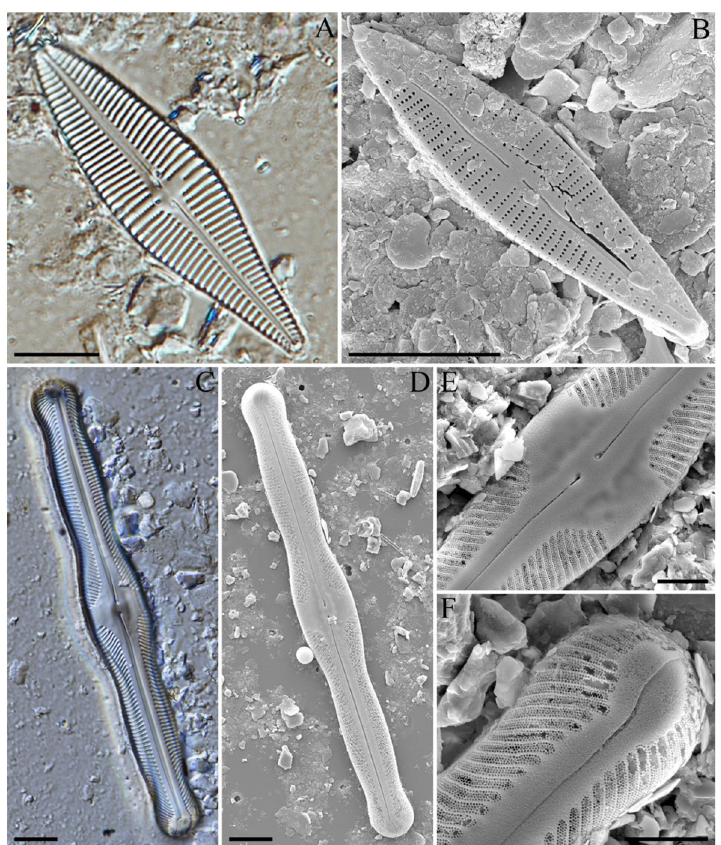
Fig. 3 Light ( A , C ) and field emission scanning electron ( B , D – F ) photomicrographs of diatoms collected from the sediment core at sampling site GG19‑01. ( A , B ) Gomphonema lacusrankala . ( C – F ) Pinnularia diandae. Scale bars: